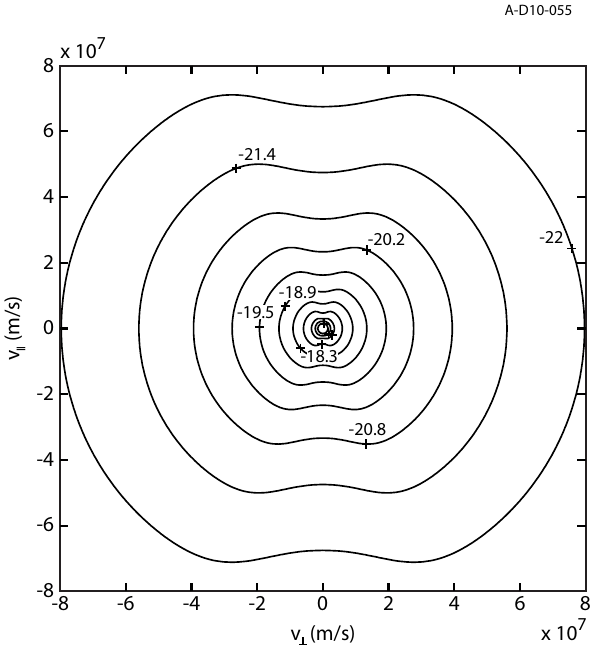
Fig. 11b. Contours of the PSD determined from the analytical model described by Eq. (1), but now using parameters for the event of Fig. 11a.